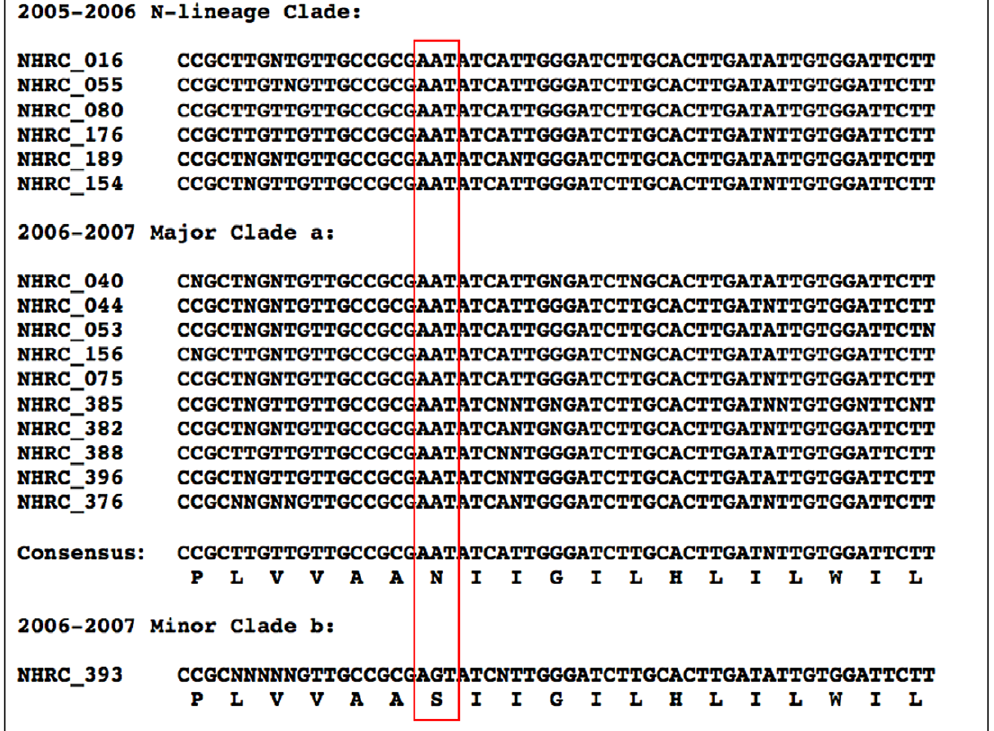
Figure 3. Alignment of M (matrix) gene sequences from 18 of 25 A/H3N2-positive specimens, representing three circulating 2006– 2007 seasonal clades described by Nelson et al [11]. Twenty-four of the samples represent amantadine-resistant N-lineage or clade-a specimens, and each of these reveals -AAT- as asparagine (N) codon 31 of the M2 peptide (locus outlined in red box), a genotype consistent with the amantadine resistance phenotype. The matrix gene sequence of the single outlier clade-b sample (NHRC_393) reveals -AGT- as serine (S) codon 31 of the M2 peptide, a genotype consistent with the amantadine-sensitive phenotype.